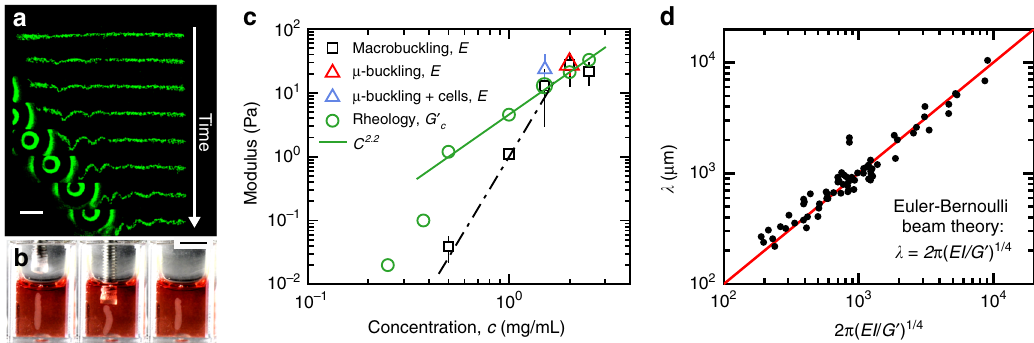
Fig. 3 Determining the microbeam moduli to predict λ . a Microbuckling: we mount our 3D printer atop an inverted epi fl uorescence microscope and print horizontal beams made from 2.0 mg/mL collagen-1 supplemented with 1 μ m fl uorospheres to enable imaging. After gelation, we apply a large axial load to the beam, observing clear transverse undulations. b Macrobuckling: we 3D print vertical beams made from 0.5 – 2.5 mg/mL collagen-1 and load them axially, also observing buckling. (Scale bar: 5 mm). c For both macrobuckling and microbuckling tests, we determine the beam modulus, E , from EB theory. For comparison, we plot G ’ of collagen networks measured with shear rheology. The solid green-line agrees with previous reports on collagen rheology; the dashed line is used for estimating E between measured datapoints (0.5 and 1.5 mg/mL collagen). Errorbars are ±one standard deviation. d Euler – Bernoulli (EB) theory predicts the relationship between the beam elastic modulus, E , the supporting material shear modulus, G ’ , the second moment of area, I , and the wavelength, λ . With no fi tting parameters, measurements of λ from many different beams are predicted ( R 2 = 0.93). ( n = 69 separate measurements displayed. See Supplementary Fig. 7 for breakdown by cell type.)